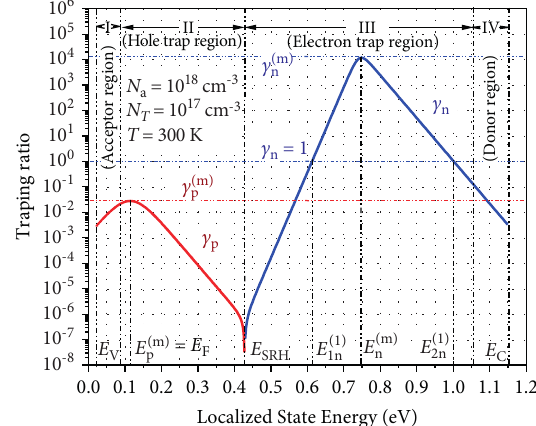
Figure 2: Room-temperature localized state energy dependence of c c p (red curve) and n (blue curve) for p-type Si with shallow acceptor density 1018cm − 3 and localized state density 1017cm − 3